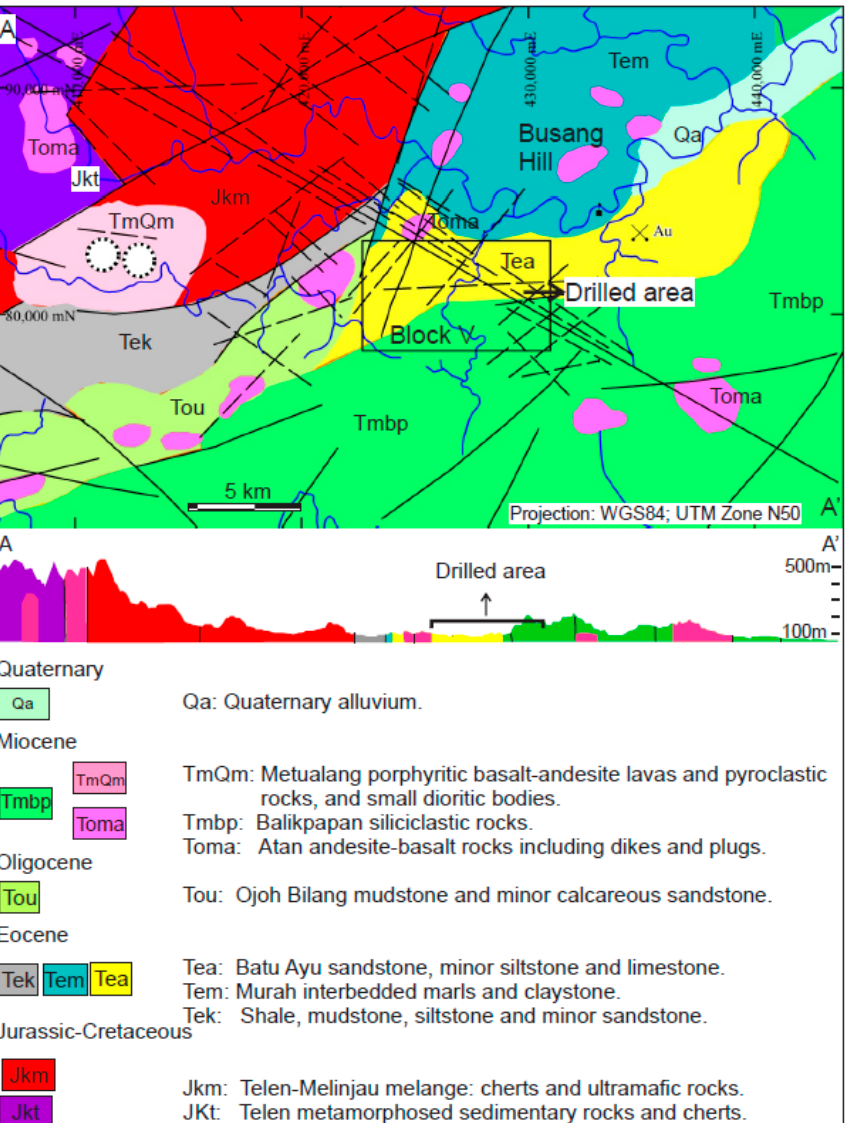
Figure 2. District geology of the Busang prospect showing the eastern side of the Muller or Kalimantan Ranges, the NE-trending Paleogene-Neogene volcanic centers, and lineaments (solid) (after Atmawinata et al. [20]). Other structures (dash line) were interpreted from an Shuttle Radar Topography Mission (SRTM) from the USGS (this study). Utoyo [3] placed the Busang field camp on the south side of the andesite-basalt plug, locally known as the Busang Hill. A placer gold mining operation was located several kilometers northeast of the property (“Au” [3]). The topographic profile of the A-A’ cross section was extracted from the SRTM. Contacts and faults were drawn as vertical in the absence of structural data.